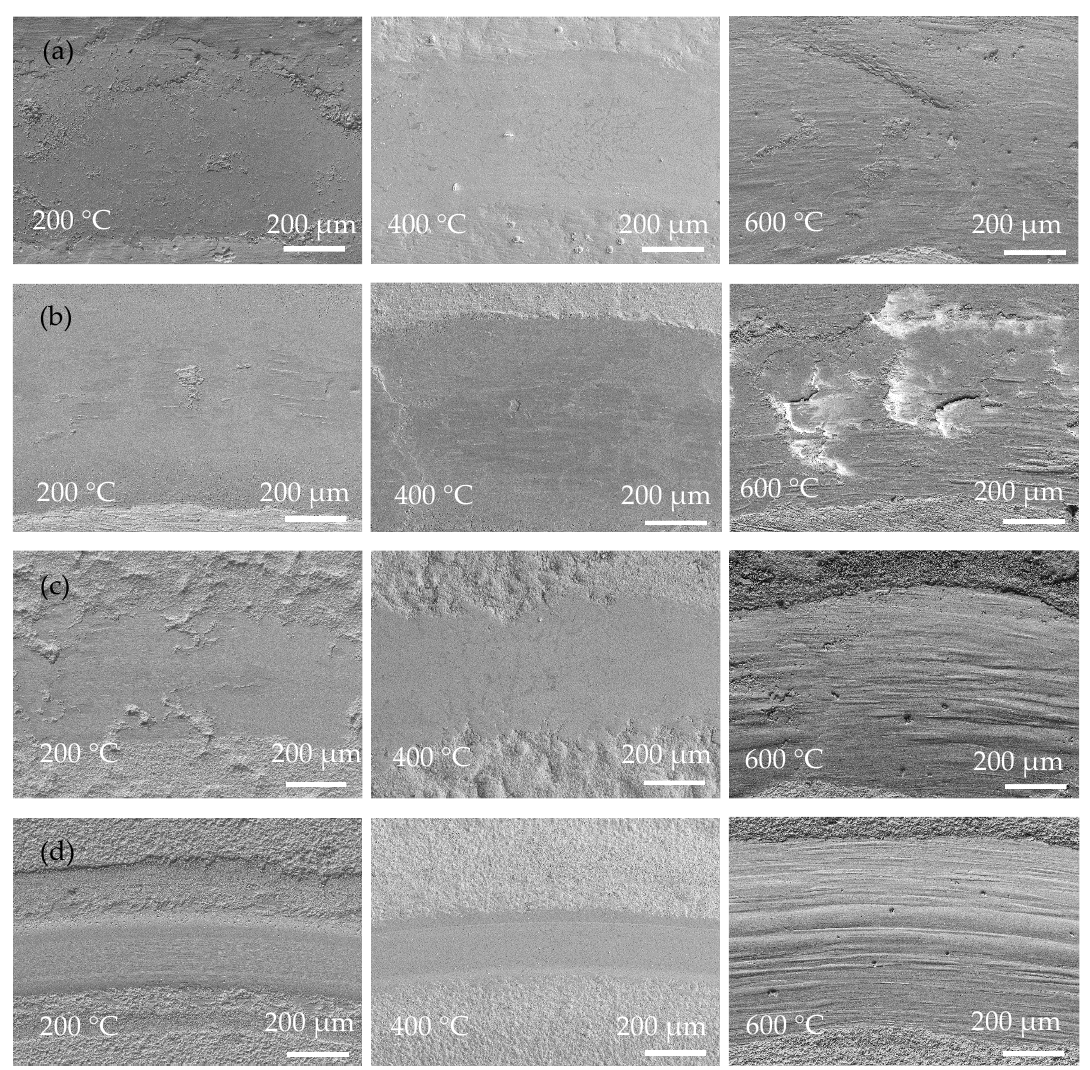
Figure 8. Low-magnification surface morphologies of wear scar of coatings operated at 200, 400, and 600 ◦ C: ( a ) Ni-P; ( b ) Ni-P-Si 3 N 4 -WS 2 , 0.5 g/L; ( c ) Ni-P-Si 3 N 4 -WS 2 , 1.5 g/L; ( d ) Ni-P-Si 3 N 4 -WS 2 , 2.5 g/L.